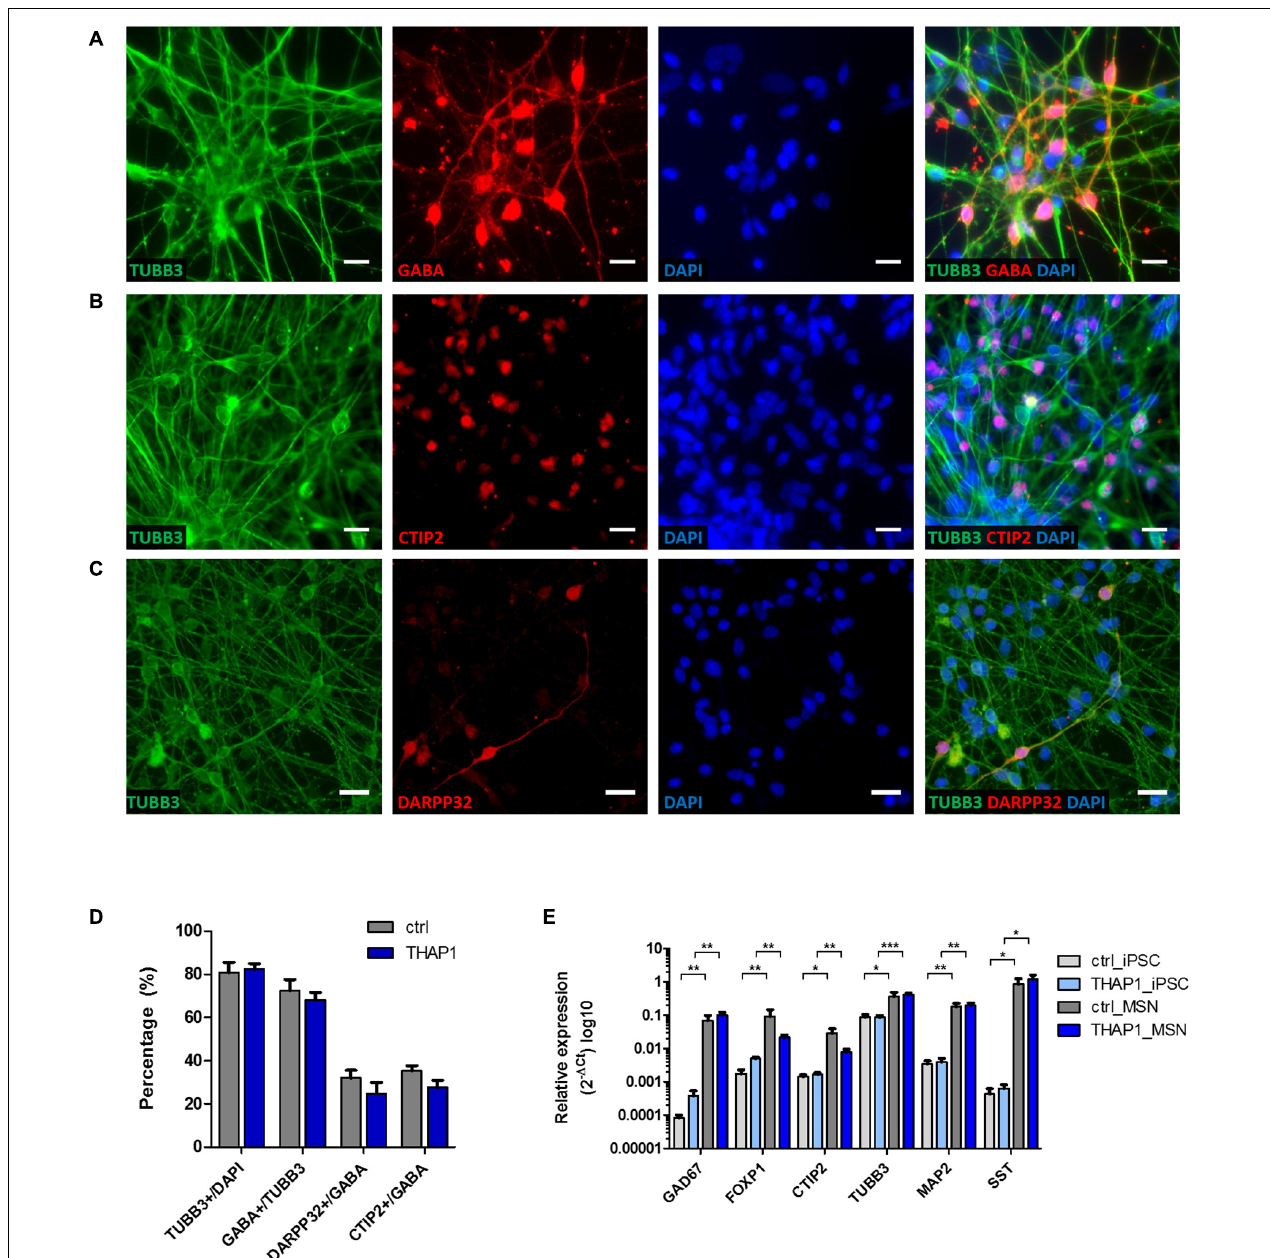
FIGURE 1 | Differentiation of iPSCs derived from DYT-THAP1 mutation carriers and healthy controls into striatal medium spiny neurons (MSNs). (A–C) Mature MSNs at day 70 ( ± 7 days) of differentiation expressed the neuronal markers β -tubulin III (TUBB3), γ -aminobutyric acid (GABA) and MSN-specific striatal markers dopamine- and cAMP-regulated neuronal phosphoprotein 32kDa (DARPP32) and COUP TF1-interacting protein 2 (CTIP2) as shown by representative images of immunofluorescent stainings. Nuclei were stained with 4,6-diamidino-2-phenylindole (DAPI). Scale bar indicates 20 µ m. (D) About 80% of DAPI-stained MSNs expressed the neuronal marker TUBB3, of which the majority were GABA-positive cells. About 30% of GABA-positive cells co-expressed DARPP32 and CTIP2 showing terminal differentiation into striatal MSNs. Quantitative estimation of neuronal and MSN-specific markers was similar for THAP1 and control MSNs. Data are presented as means ± SEM from one to two independent differentiations for each control and THAP1 line. (E) Expression analysis of iPSCs and MSNs derived from DYT-THAP1 patients and healthy controls by quantitative real-time PCR. Compared with iPSCs, THAP1 and control MSNs expressed significantly elevated levels of markers for neuronal origin (FOXP1, forkhead box protein P1; TUBB3, β -tubulin III; MAP2, microtubule-associated protein 2), GABAergic origin (GAD67, glutamic acid decarboxylase) and MSN-specific striatal origin (CTIP2, COUP TF1-interacting protein 2). Expression of neuronal, GABAergic and MSN-specific markers was similar for THAP1 and control MSNs. Data are presented as means ± SEM in logarithmic scale (log 10 ) from at least two independent differentiations for control and THAP1 lines (* p < 0.05, ** p < 0.01, *** p < 0.001, parametric t -test or non-parametric Mann-Whitney test).